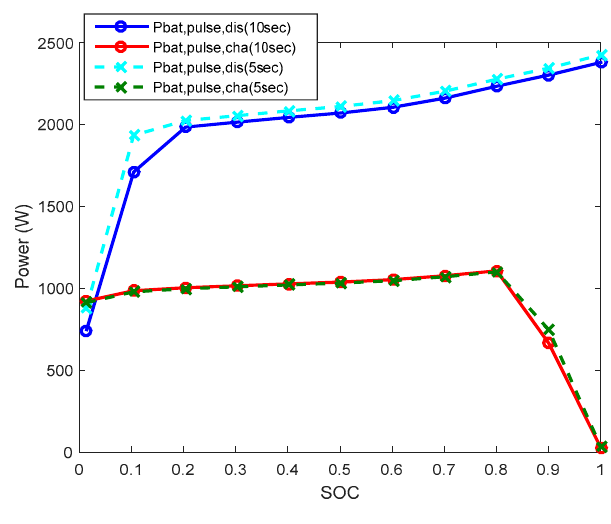
Figure 11. The proposed and conventional pulse power capability of the 12S1P battery module. Electronics 2019 , 7 , x FOR PEER REVIEW